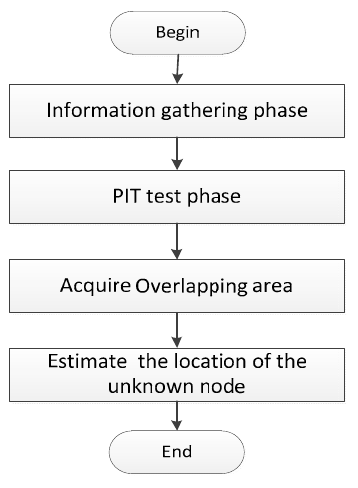
Figure 2. The main phase of APIT.